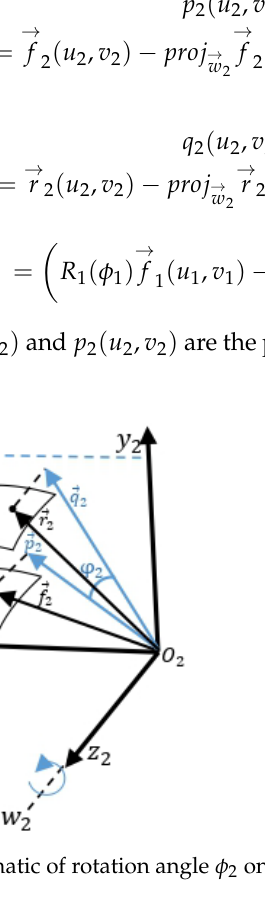
Figure 2. Schematic of rotation angle